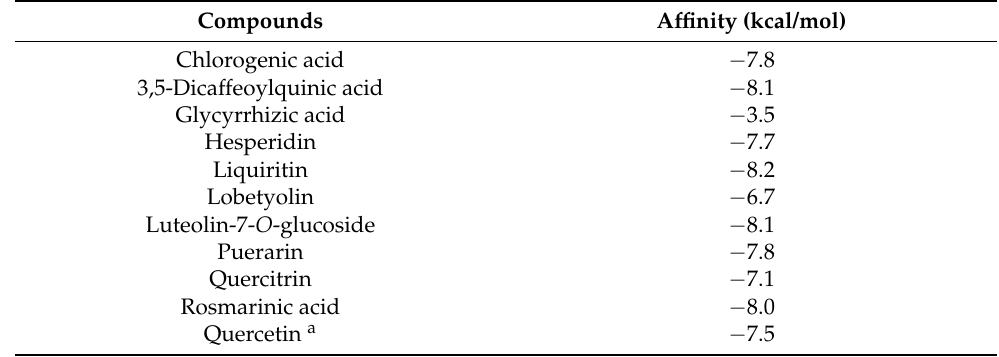
Table 5. Binding energies of active compounds and SARS-CoV-2 spike protein with human ACE2 receptors calculated in